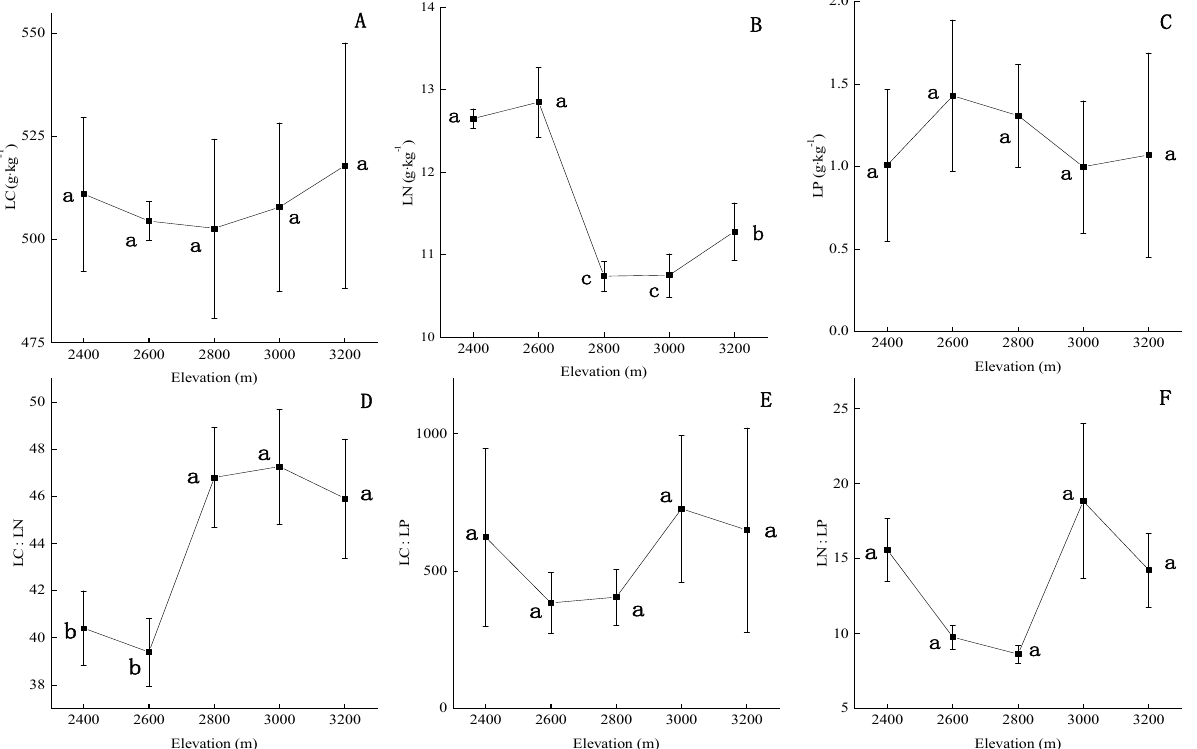
Figure 2. P. crassifolia LC ( A ), LN ( B ), and LP ( C ) and LC:LN ( D ), LC:LP ( E ), and LN:LP ( F ) ratios at different elevations. LC = leaf C concentration; LN = leaf N concentration, LP = leaf P concentration. For individual plots, non-matching lowercase letters (e.g., a, b, …) indicate a significant difference in leaf stoichiometry between elevations.